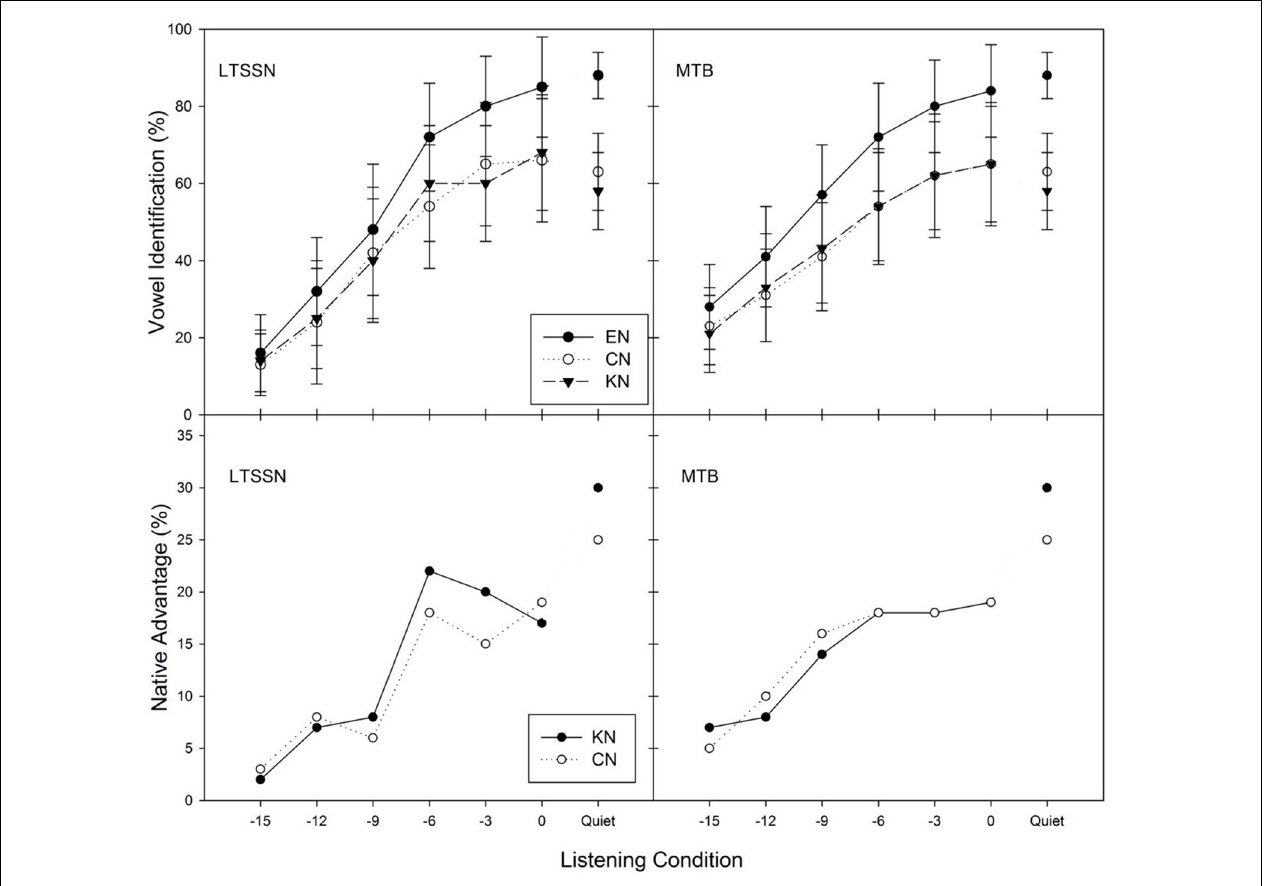
FIGURE 1 | Average percent correct vowel identification scores and standard errors (upper), and native advantage (lower) over the 12 vowels as a function of listening conditions in steady-state noise,